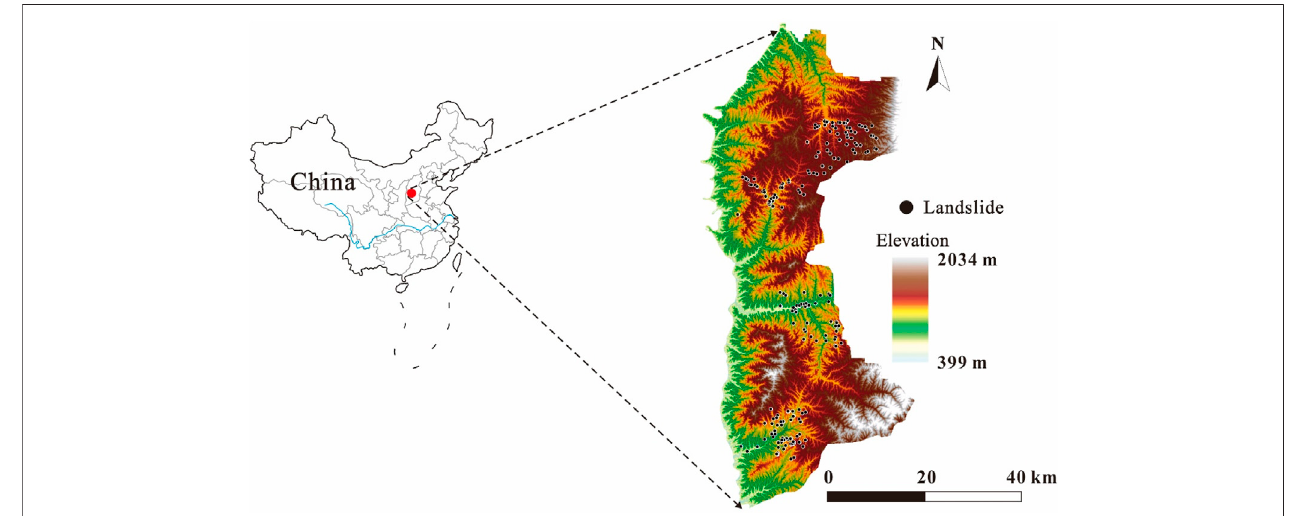
FIGURE 1 | Landslide spatial distribution map.